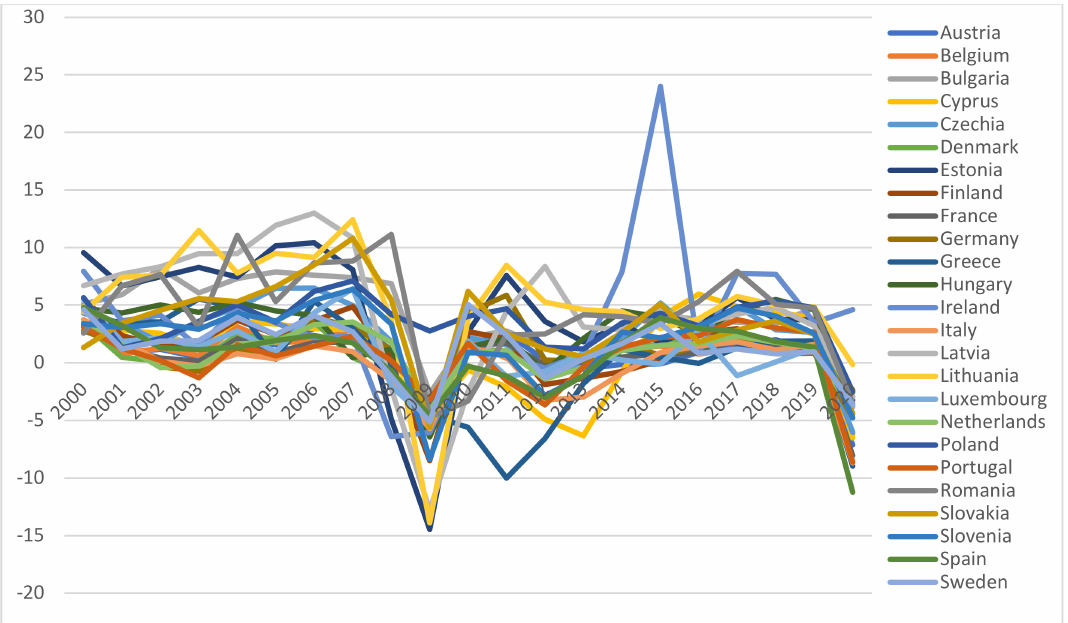
Figure 3. Evolution of GDP growth rate for 25 EU countries during